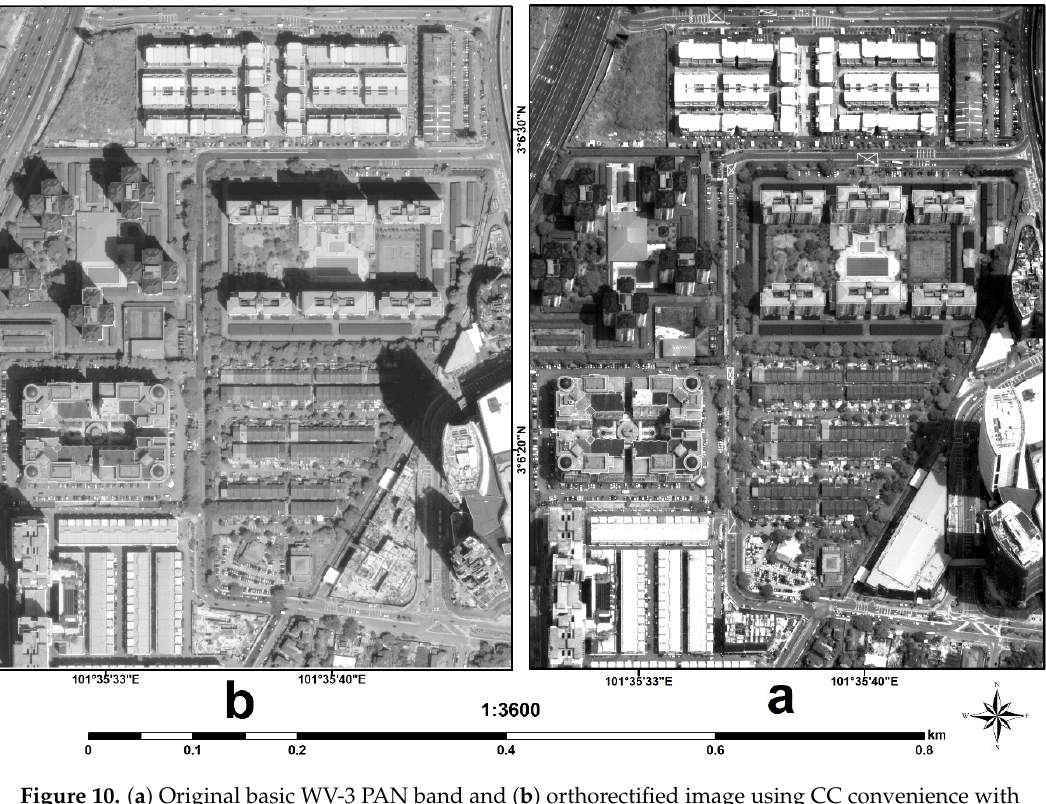
Figure 10. ( a ) Original basic WV-3 PAN band and ( b ) orthorectified image using CC convenience with 80 GCPs.